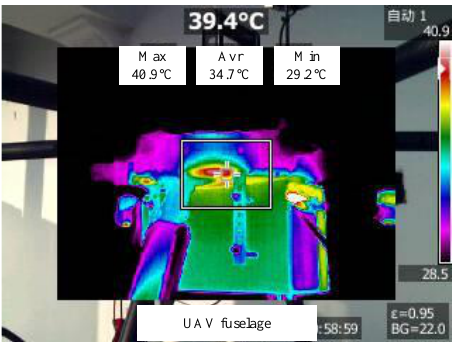
Figure 25. Carbon fiber fuselage temperature with nanocrystalline.